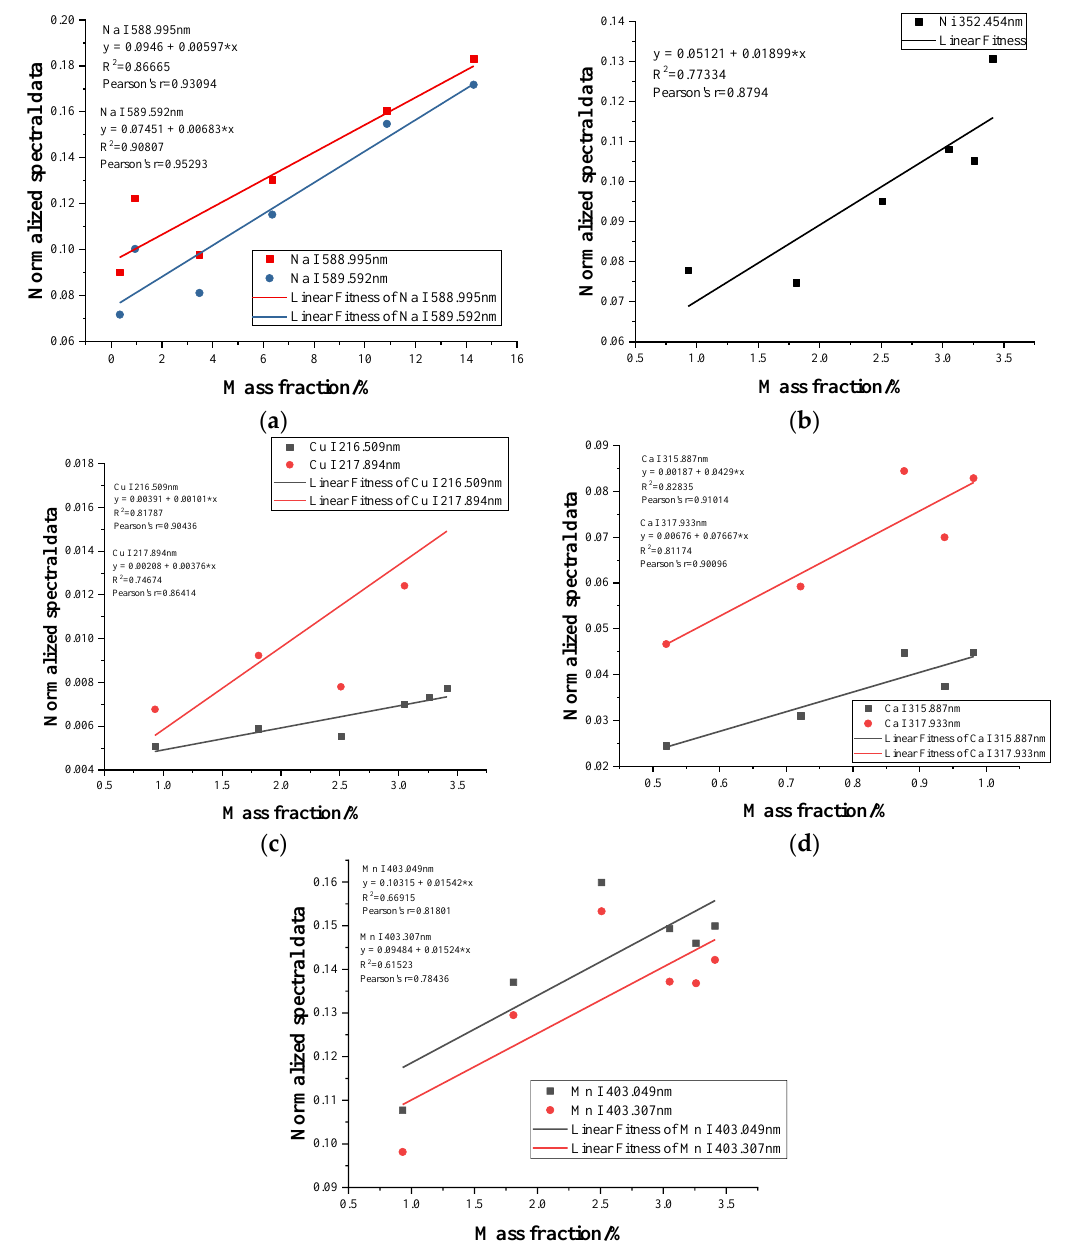
Figure 6 . Linear relationship between the ion concentration of elements and their corresponding normalization spectral data, where ( a–e ) correspond to Na, Ni, Cu, Ca and Mn. The calibration curve method was obtained with correlation coefficient (R 2 ) values of 0.86665 To evaluate the measurement sensitivity and precision, the limit of detection (LOD) was calculated, and 0.90807 for Na (589.592 nm and 588.995 nm), 0.77334 for Ni, 0.81787 and 0.74674 for Cu (216.509 as in Equation (2): S . D . nm and 217.894 nm), 0.82835 and 0.81174 for Ca (315.887 nm and 317.933 nm) and 0.66915 and LOD = 3 × 0.61523 for Mn (403.049 nm and 403.307 nm), as shown in Figure 6. The quantitative analysis of the where S.D. is the standard deviation of the response, and S is the slope of the calibration curve. The smallest LOD was selected in the calculation results at different wavelengths of the same element. From the known primary slope and background intensity, the remaining surface Na (589.592 nm), Ni (352.454 nm), Cu (324.754 nm), Mn (403.049 nm), and Ca (317.933 nm)